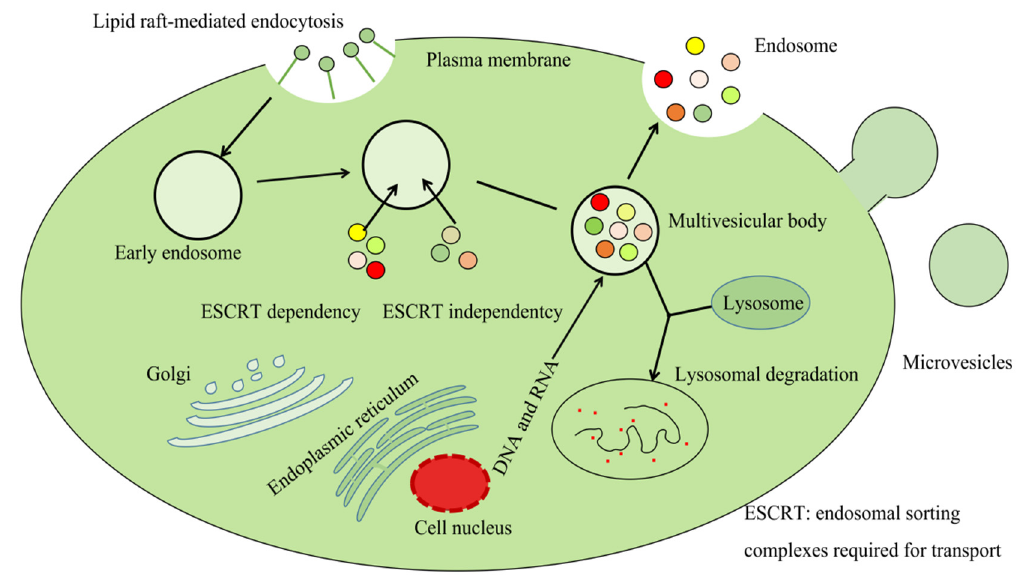
Figure 1. The schematic diagram of the synthesis and release of exosomes.